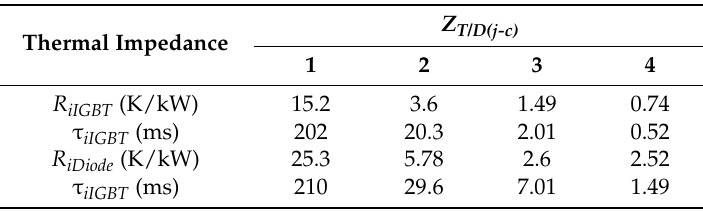
Table 3. Module thermal parameters.